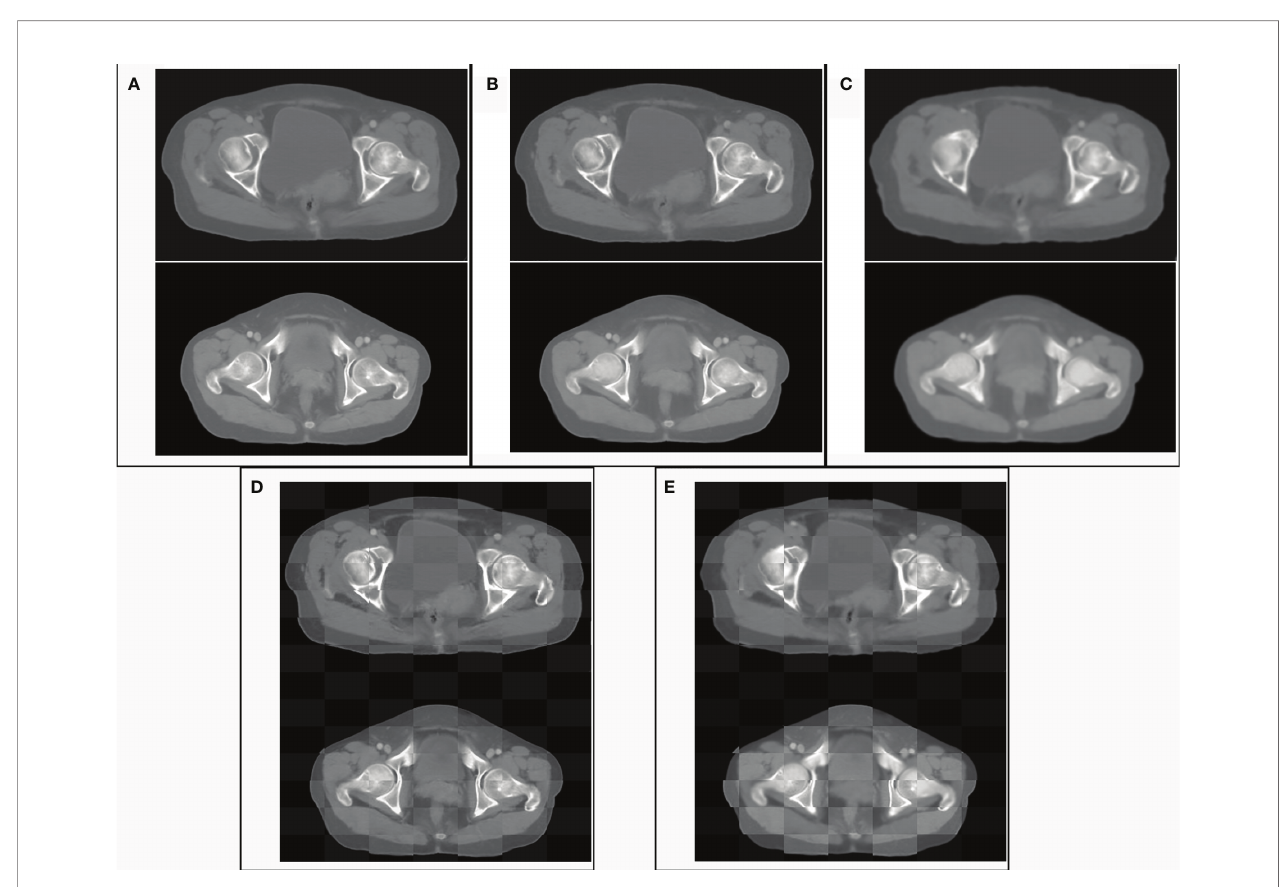
FIGURE 7 | Results of pseudo-CT images obtained by adding gradient loss function and not adding it in CycleGAN. (A) CT gt. (B) pseudo CT obtained by CycleGAN with gradient loss. (C) pseudo CT obtained based on CycleGAN without gradient loss. (D) Thecomparison result of (A, B) . (E) Comparison result of (A, C) .